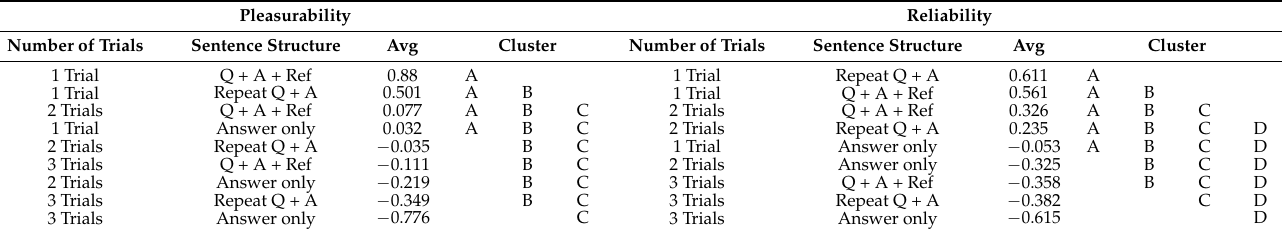
Table 4. Emotional classification using Tukey